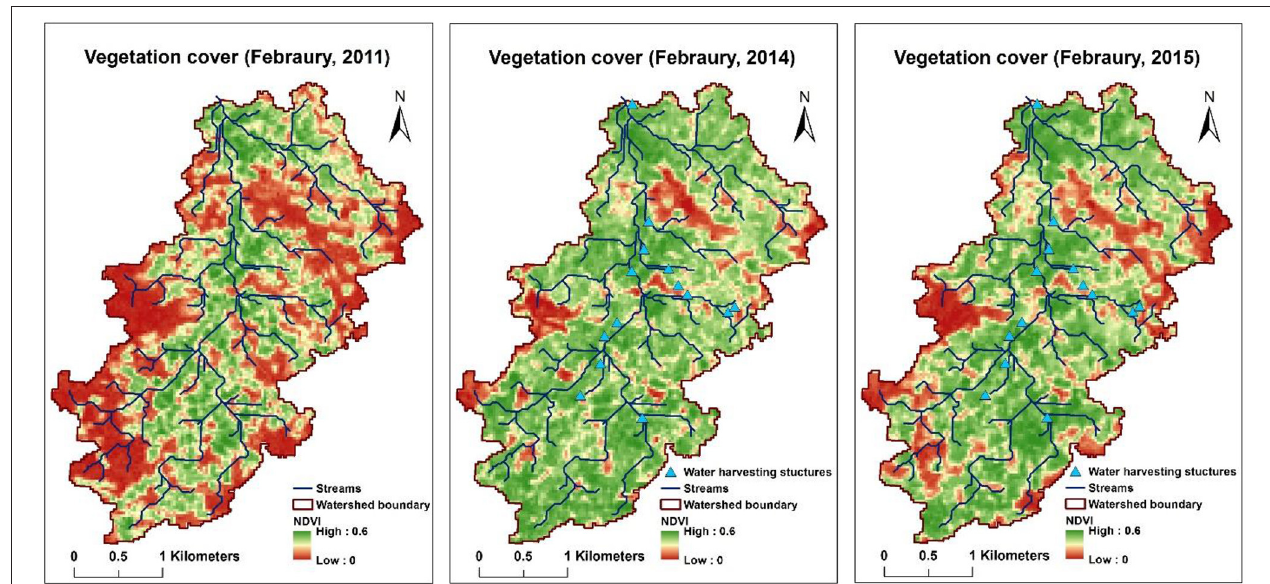
FIGURE 8 | NDVI mapping from remote sensing during February represents rabi crop area at Parasai-Sindh watershed before (2011) and after (2014 and 2015) the watershed interventions. Rainfall = 2010–11: 1,190mm; 2013–14: 1,270mm; 2014–15: 520mm.